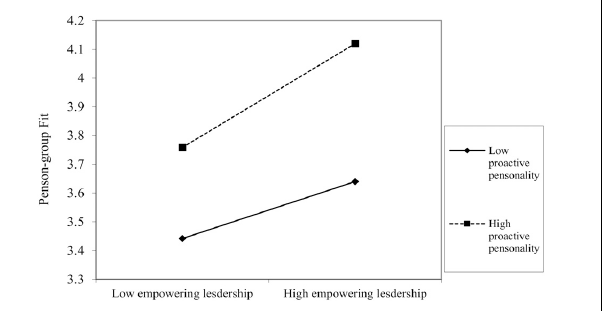
FIGURE 3 | Interactive Effect of empowering leadership and proactive personality on person-group